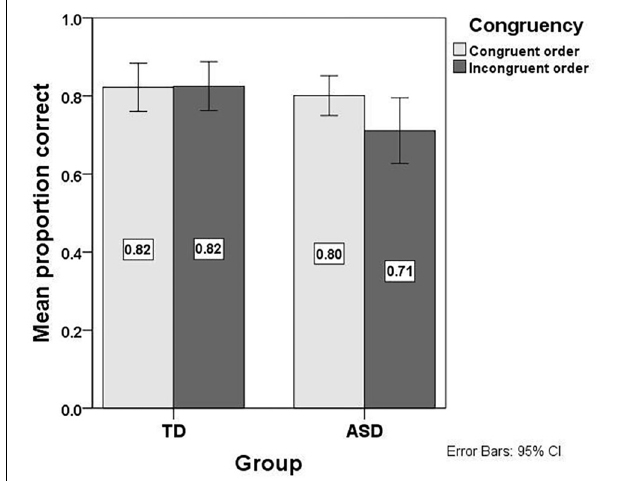
FIGURE 3 | Mean proportion of correct responses in the language comprehension task per Congruency condition (Congruent vs. Incongruent) and second-order Theory of Mind (ToM2) group (low ToM2: ≤ median vs. high ToM2: > median; median = 0.75). Background information about the two groups plotted in this figure regarding their ToM2 performance, as mean proportions of correct responses on the second-order false belief (FB) questions in the FB task: Low ToM2 group: 0.38; High ToM2 group: